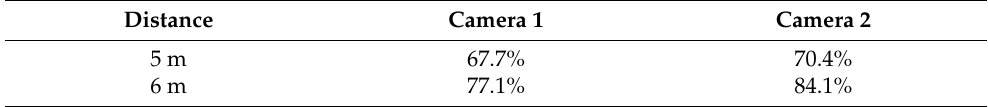
Figure 11. Enhanced and fused optical and sonar images taken at different distances of 5 and 6 m from the fusion system, ( a ) enhanced optical images (top and bottom rows are images measured from camera 1 and 2 at each distance, respectively), ( b ) enhanced sonar images, ( c ) overlayered optical color image on the sonar image. Table 4. IoU result value by distance and camera.